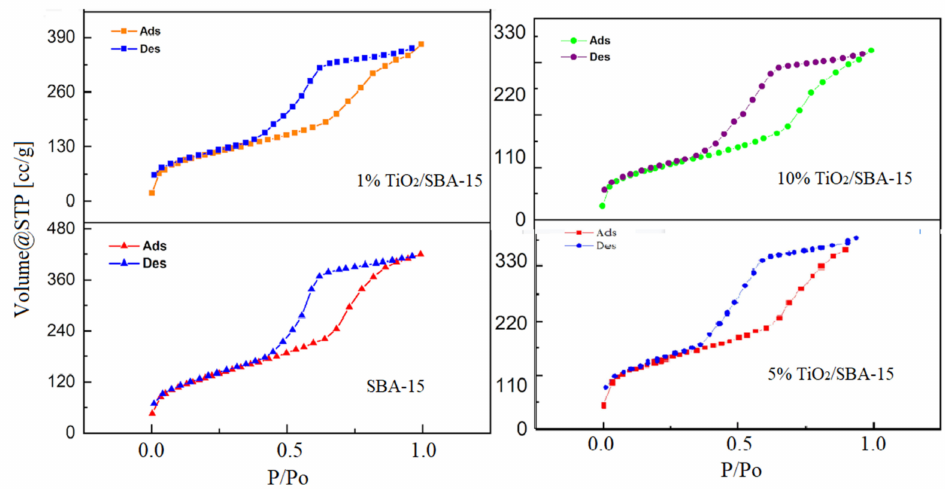
Figure 4. Isotherm nitrogen adsorption-desorption of SBA-15 before and after titania impregnation.